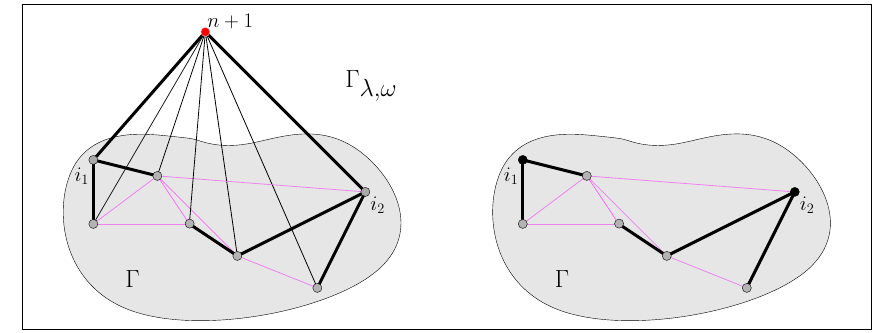
Figure 4: A spanning tree ˆ F (left) and the induced 2-rooted forest F 2